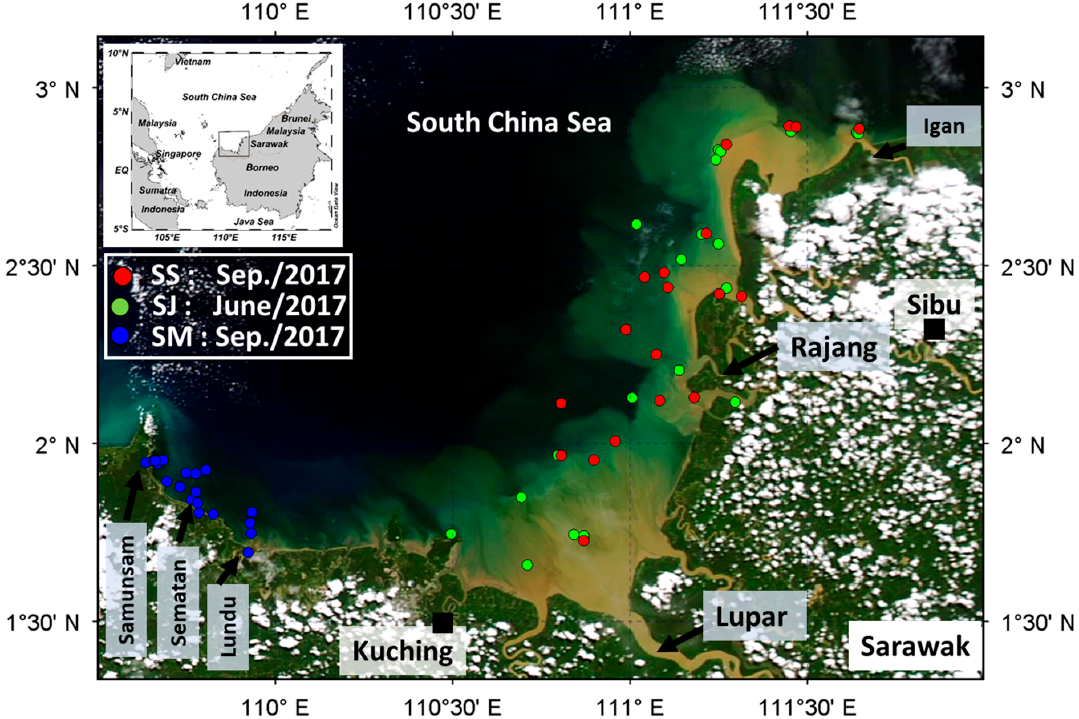
Figure 1. Map of Sarawak indicating the spatial extent of field sampling during June and September 2017.